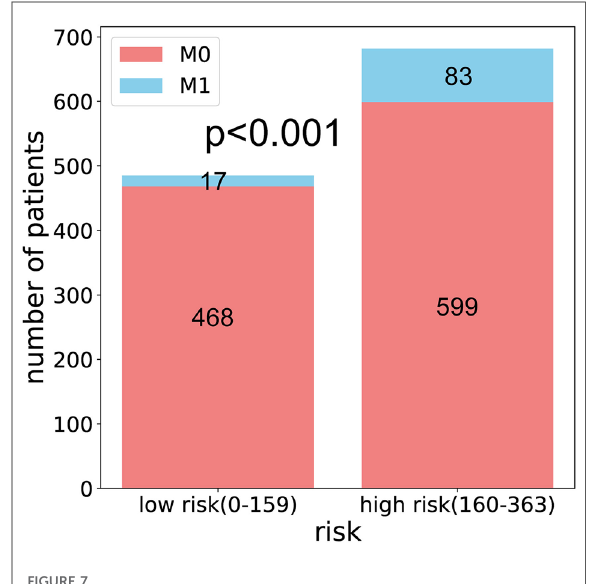
FIGURE 7 Column chart for risk strati fi cation of the nomogram.